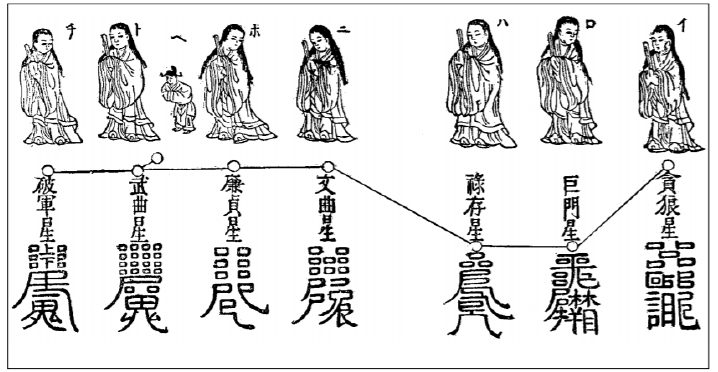
Figure 7. Illustration of the Big Dipper deities. The seven larger figures each represents a star deity, whose name was labeled below. From the right to the left, their names are: Tanlang Star, Jumen Star, Lucun Star, Wenqu Star, Lianzhen Start, Wuqu Star, and Pojun Star. The small figure represents deity of the eighth star—the Fu Star, which is discernible only under very particular conditions. From the Sutra on Prolonging Life through Worship of the Seven Stars of the Big Dipper. Taish¯o shinshü daiz¯oky¯o (The Taish¯o Tripit.aka), Vol. 21, No.